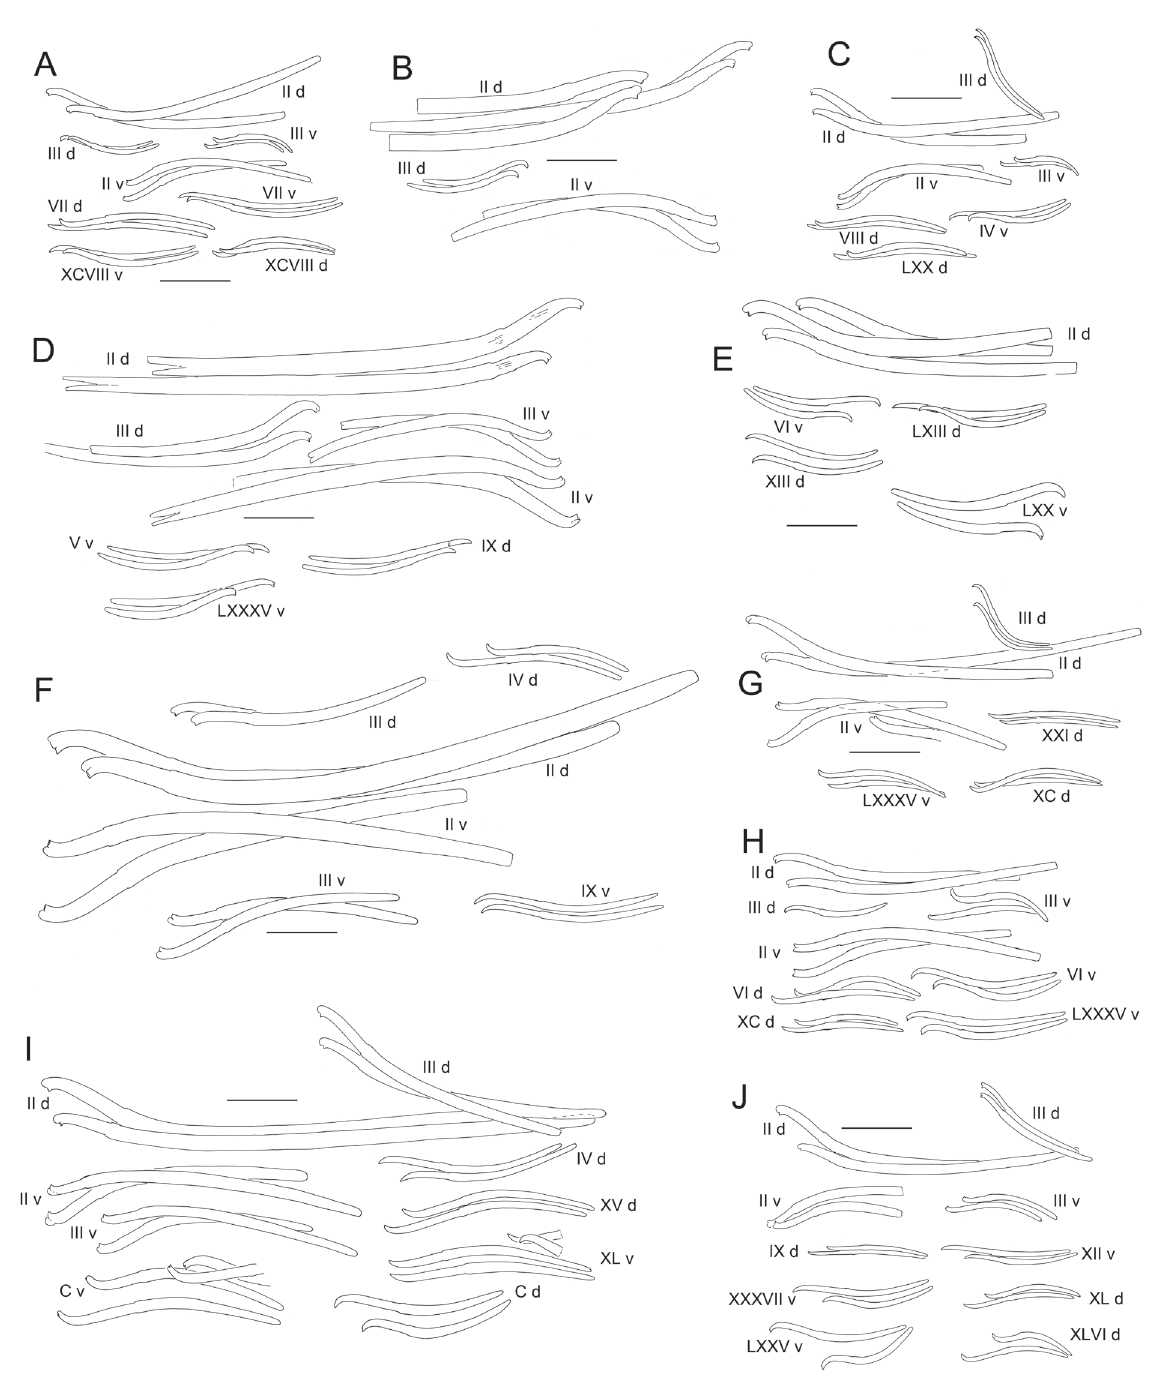
Fig. 10. Guestphalinus elephantinus Fend & Rodriguez sp. nov., various sites, arranged approximately north-south; paired chaetae; d = dorsal bundle, v = ventral. A . From Shale Creek, WA (type locality). B–C . From Clearwater River, WA; C shows II and III in relative positions at top. D . West Fork Satsop River, WA. E . Tucannon River, WA; II dorsal bundle with 1 replacement chaeta. F . Euchre Creek, OR. G . Mule Creek at Rogue River, OR; II and III dorsal are shown in relative positions. H . Spring at Peavine Ridge, OR. I – J . A mature and immature worm from Guadalupe Creek, CA; II and III shown in relative positions; XL ventral and C ventral in I have partially-developed replacements; II ventral chaetae partially-developed in J. Scale bars: 100